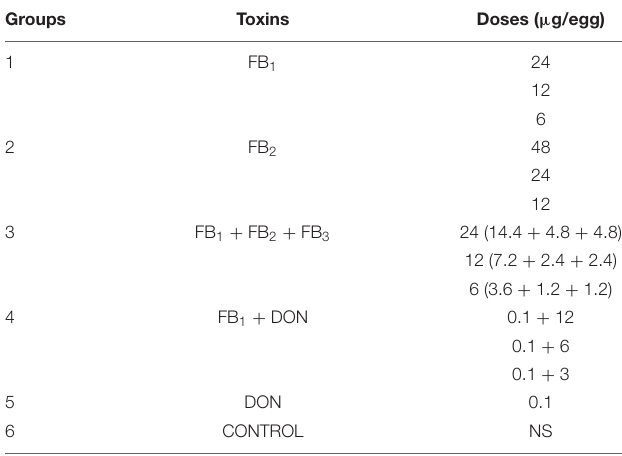
TABLE 1 | Experimental designs with mycotoxin alone or synergetic inoculations.